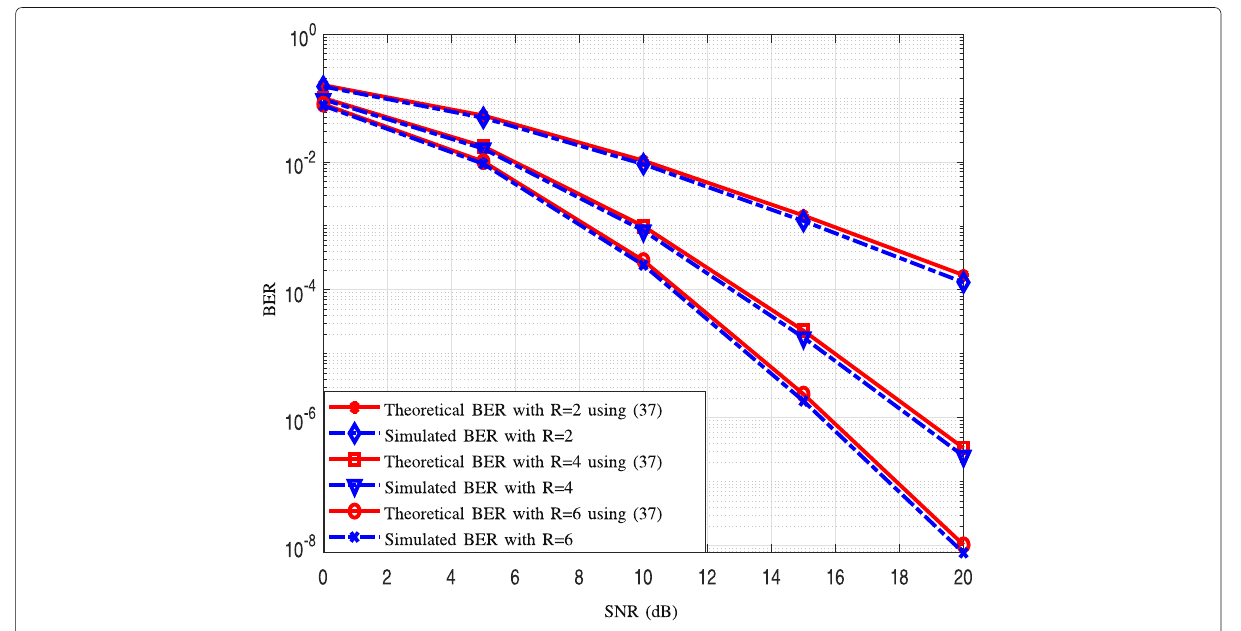
Fig. 2 Theoretical and simulated BER performance versus SNR for the suggested strategy with R = 2, R = 4, and R = 6